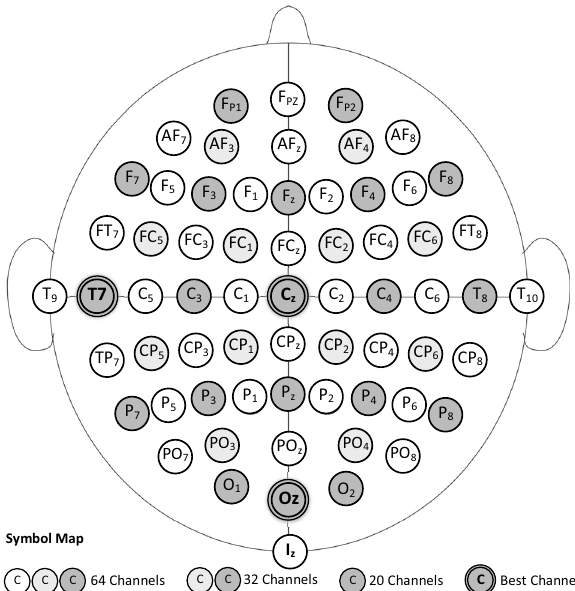
Figure 4. Position of all 64 electrodes on the scalp. Selected 32 channels are indicated by the color circles (both dark and light gray ones). Dark gray circles distinguish 20 channels of search space.